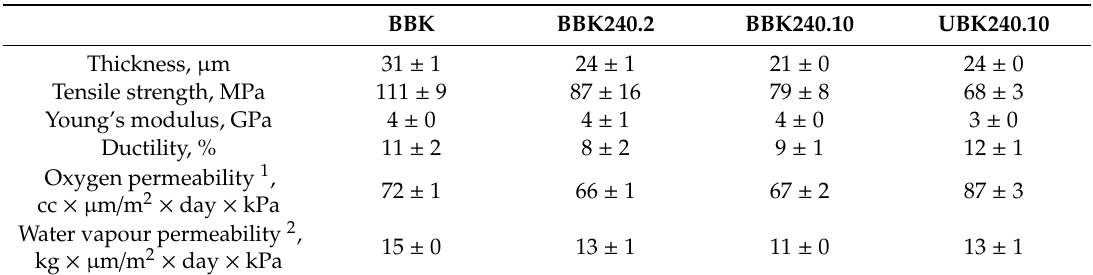
Table 4. Properties of CNF films produced from bleached (BBK) and unbleached birch kraft (UBK) pulp after hot water extraction in a flow-through system (flow rate 400 mL / min).